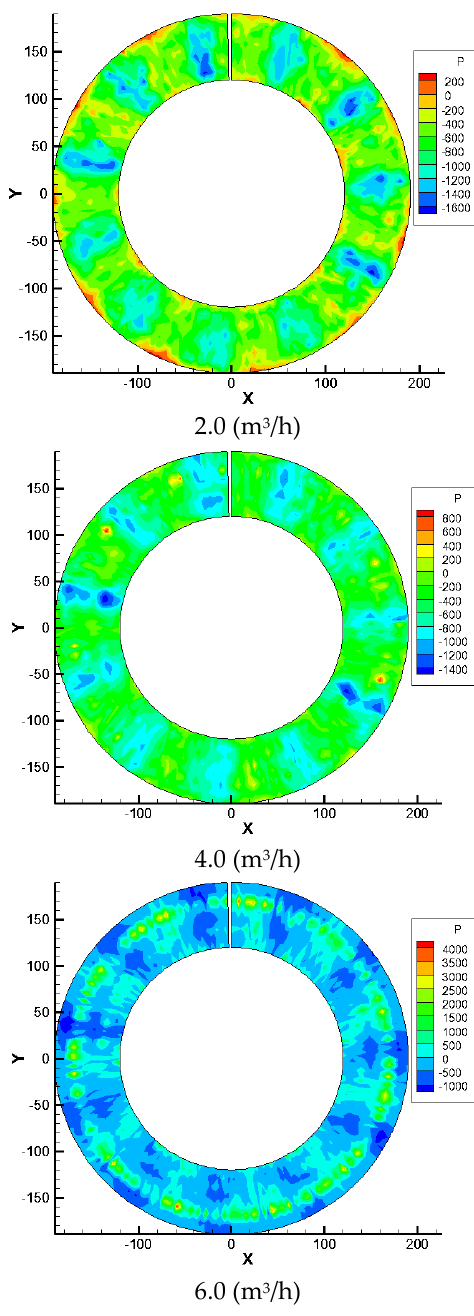
Figure 7. Dynamic pressure for different blowing–flow conditions.